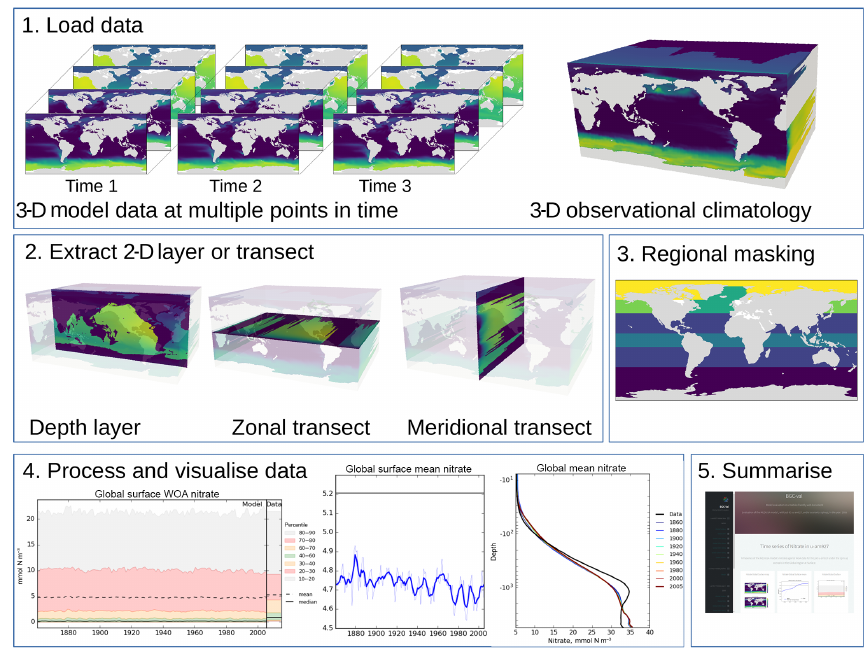
Figure 1. The five stages of the evaluation process. The first stage is the loading of the model and observational data. The second stage is the extraction of a two-dimensional array. The third stage is regional masking. The fourth stage is processing and visualisation of the data. The fifth stage is the publication of an html summary report. Note that the three figures shown in the fourth stage are repeated below in Figs. 3, 4, and